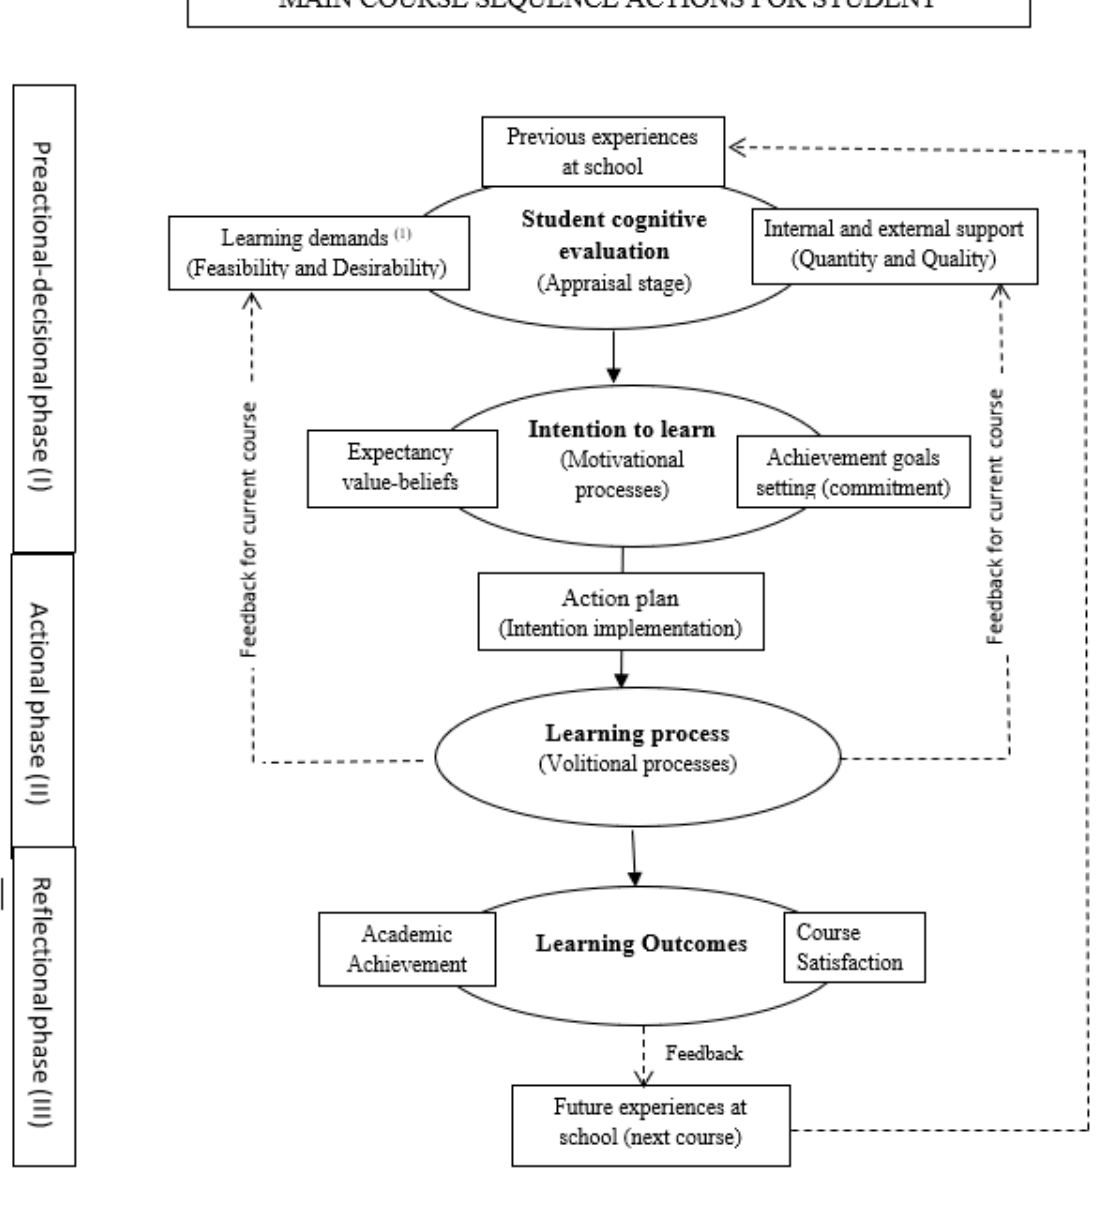
Figure 1. MOCSE diagram: the main course sequence actions for students.